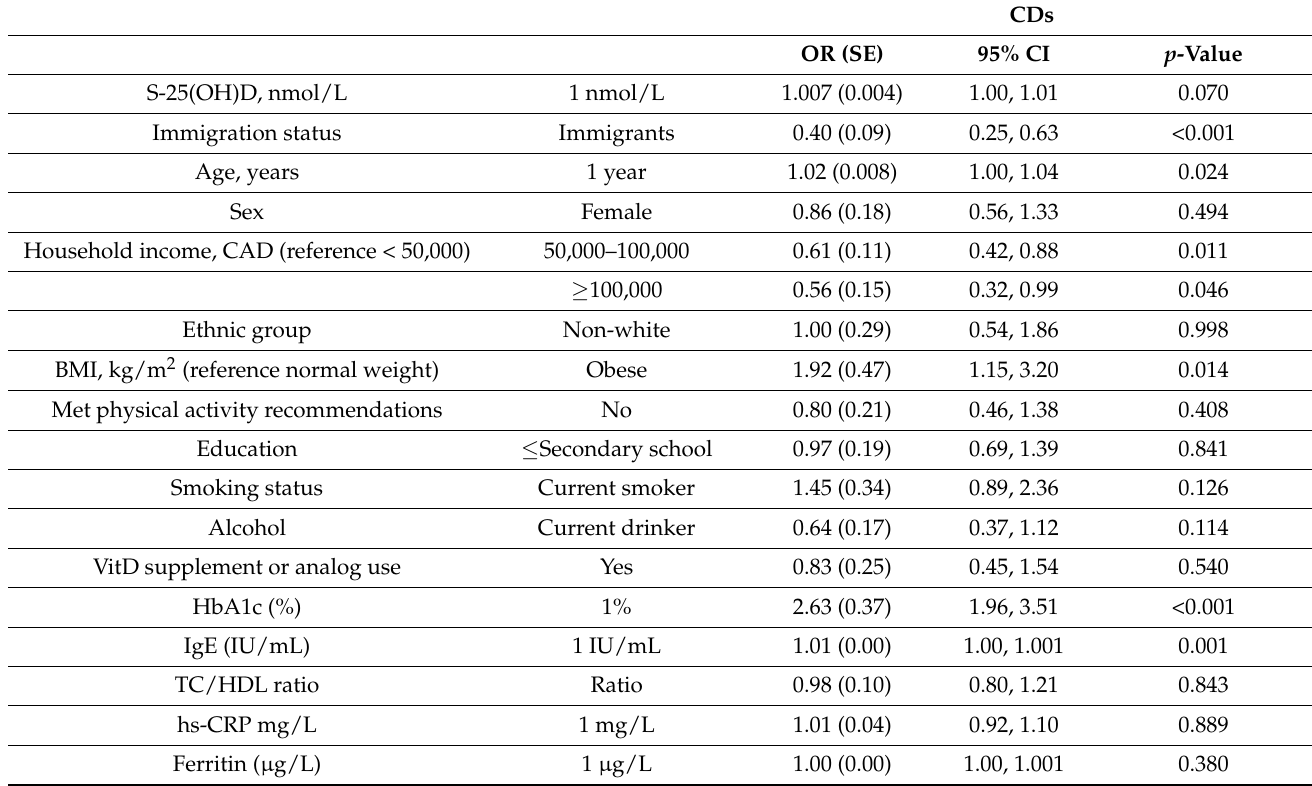
Table 5. Multivariable logistic regression analysis for chronic diseases and serum 25(OH)D (con- tentious) in a predefined